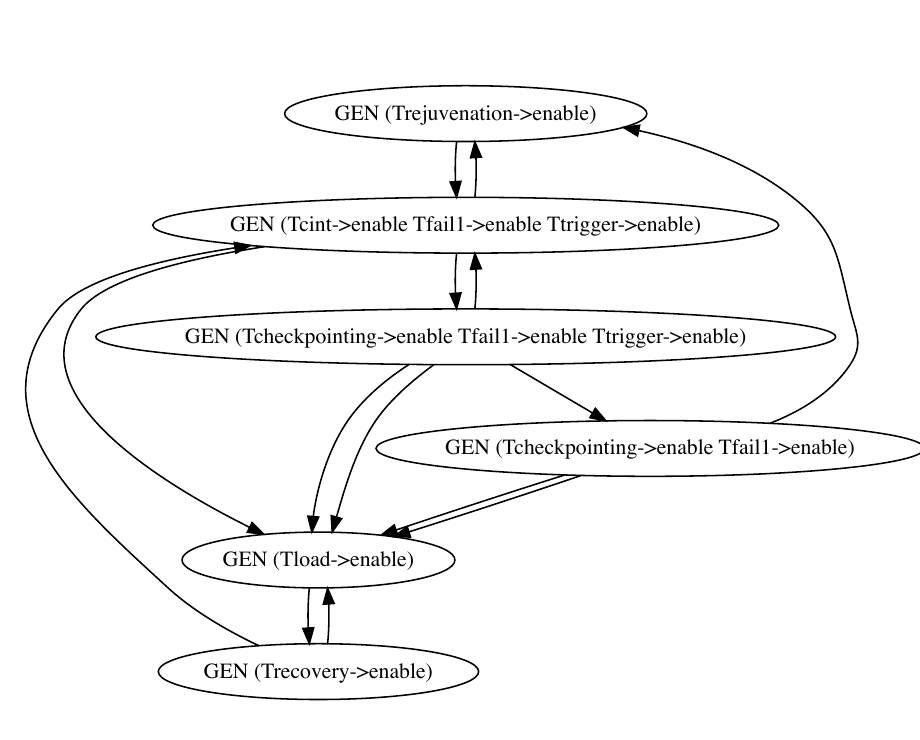
Figure 3. Reachability